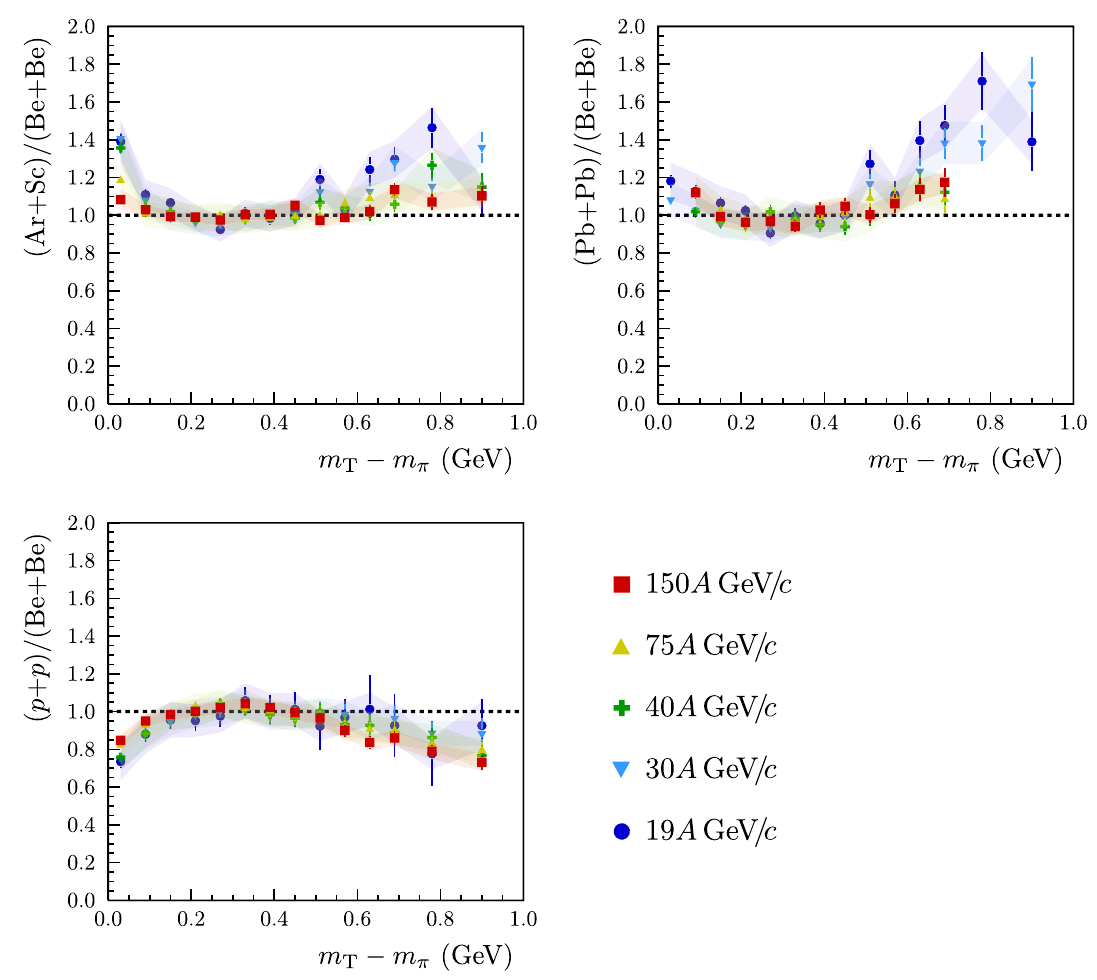
Fig. 16 The ratio of transverse mass spectra of π − mesons at mid- rapidity scaled to integral in the range 0 . 24 < m T − m π < 0 . 72 GeV: central Ar+Sc to central Be+Be, central Pb+Pb to central Be+Be and inelastic p + p to central Be+Be collisions. Statistical uncertainties